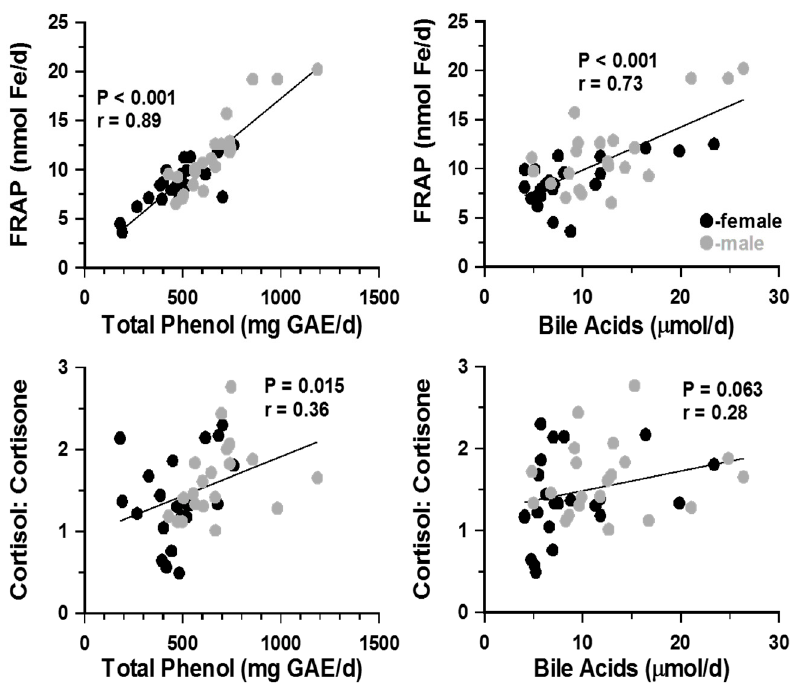
Figure 3. Cross-tabulation of urinary data showed that, irrespective of dietary intervention and gender, all three markers of oxidative stress were significantly correlated ( p < 0.001 in all casesAlthough neither urinary cortisol nor cortisone alone were associated with antioxidant levels (not shown above), the ratio of cortisol: cortisone correlated positively with TBARS, total phenols (r = 0.47, p < 0.01) and FRAP (r = 0.32, p < 0.05). Urinary levels of bile acids also correlated positively with all anti-oxidant markers (r = 0.408, p ≤ 0.001 for TBARS; r = 0.702, p < 0.001 for FRAP and r = 0.659, p ≤ 0.001 for total phenols) and also with urinary cortisol:cortisone ratio (r = 0.46; p < 0.001). Although separately, correlation patterns in males and females showed similar trends, statistically significant correlations were seen only when male and female results were pooled. FRAP = Ferric reducing antioxidant power; TBARS= Thiobarbituric acid reactive substances; GAE = Gallic acid